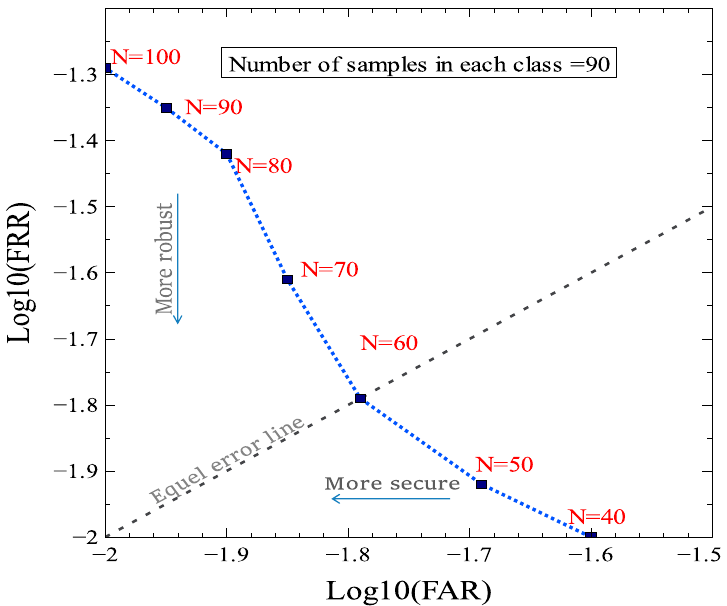
Figure 8. The values for false acceptance rate (FAR) and false rejection rate (FRR) for deep PUF.